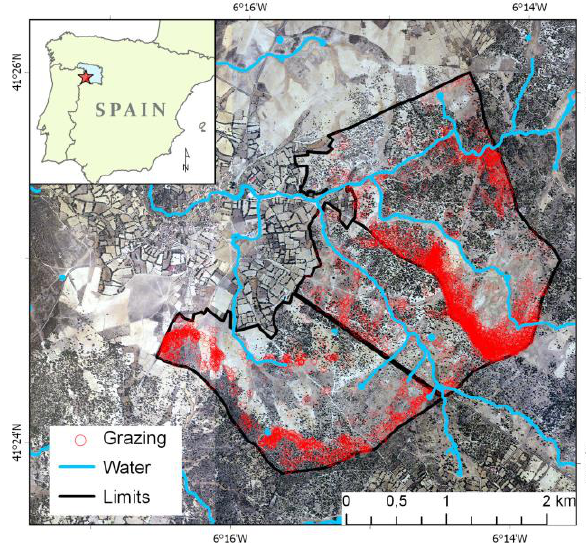
Figure 1. Location map, including GPS grazing positions of the sheep over the RGB ortophotographs.